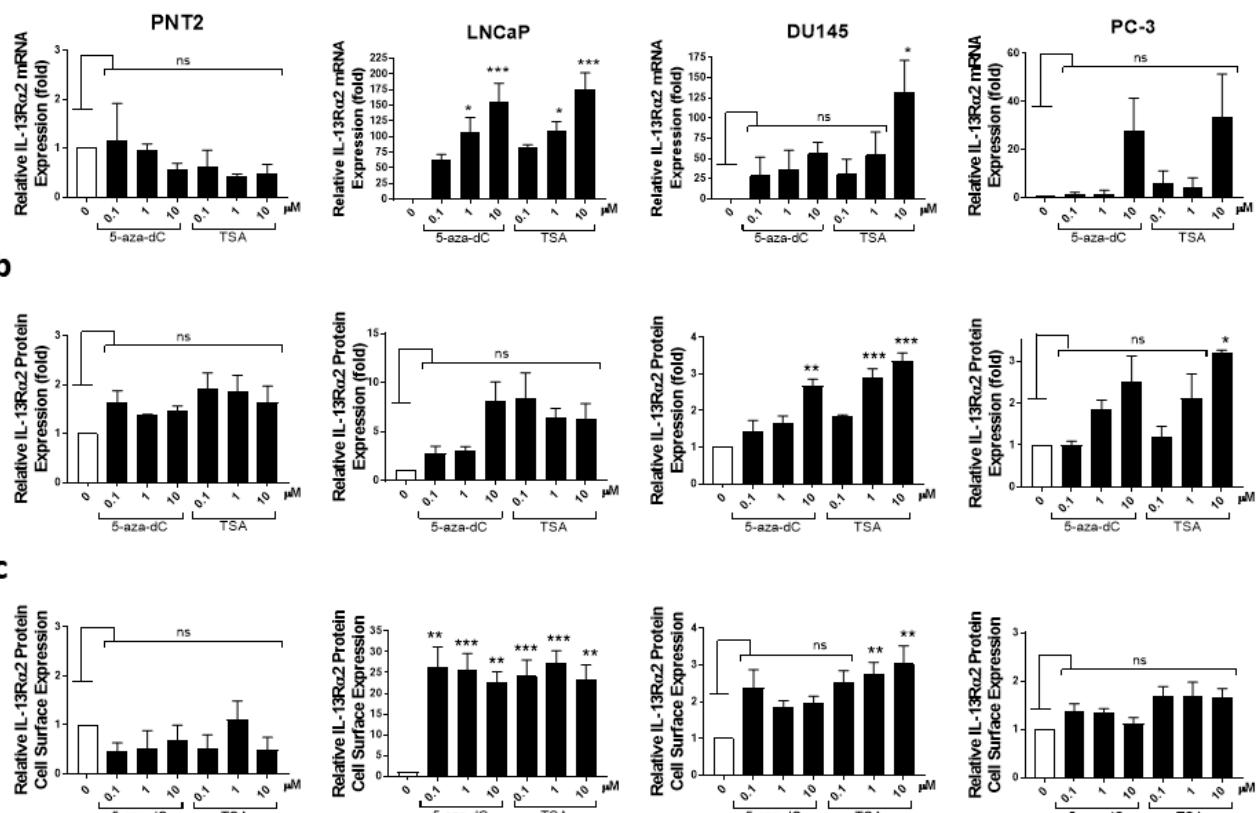
Figure 5. Analysis of IL-13R α 2 expression in prostate cancer cell lines treated with TSA or 5-aza-dC. A non-cancer cell line (PNT2) and cancer cell lines (LNCaP, DU145 and PC-3) were treated with 0.1, 1 and 10 µ M of TSA or 5-aza-dC for 24 h. ( a ) RT-PCR analysis of IL-13R α 2 mRNA expression in non-cancer and cancer cell lines. ( b ) Western blot analysis of IL-13R α 2 protein expression in non- cancer and cancer cell lines. Quantification of IL-13R α 2 protein expression was performed via den- sitometric analysis and normalising to housekeeping protein ( α -Tubulin) expression. ( c ) Cell surface expression of anti-IL-13R α 2 was assessed by subjecting non-permeabilised cells to ELISA. All West- ern blots and RT-PCR values are normalised to housekeeping controls. The data are mean ± SEM (error bars represent SEM) values of three independent experiments. IL-13R α 2 expression levels in